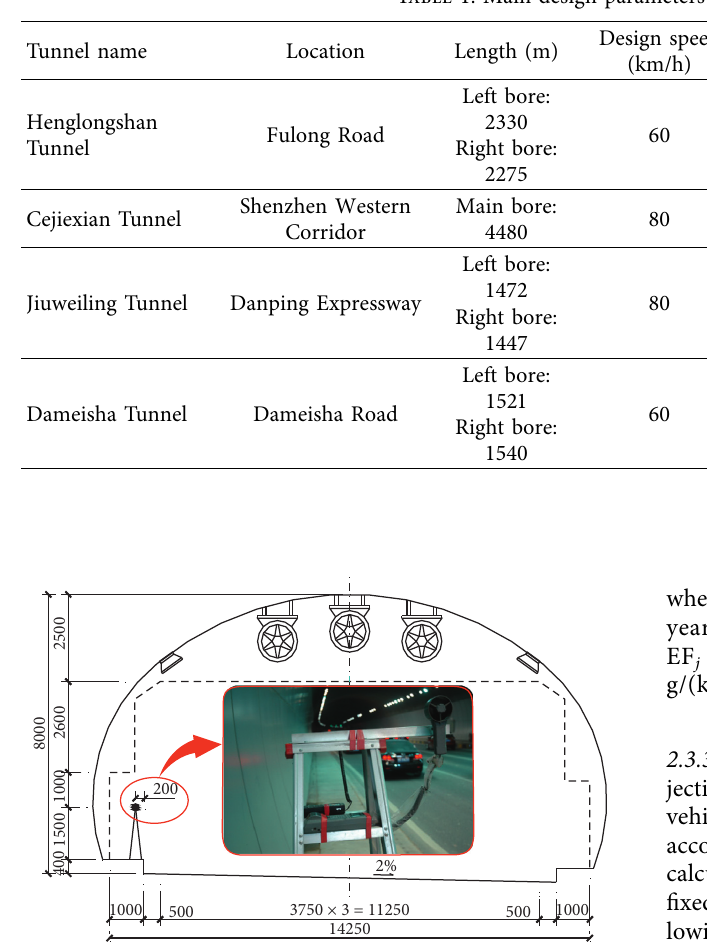
Table 1: Main design parameters of the four tunnels.